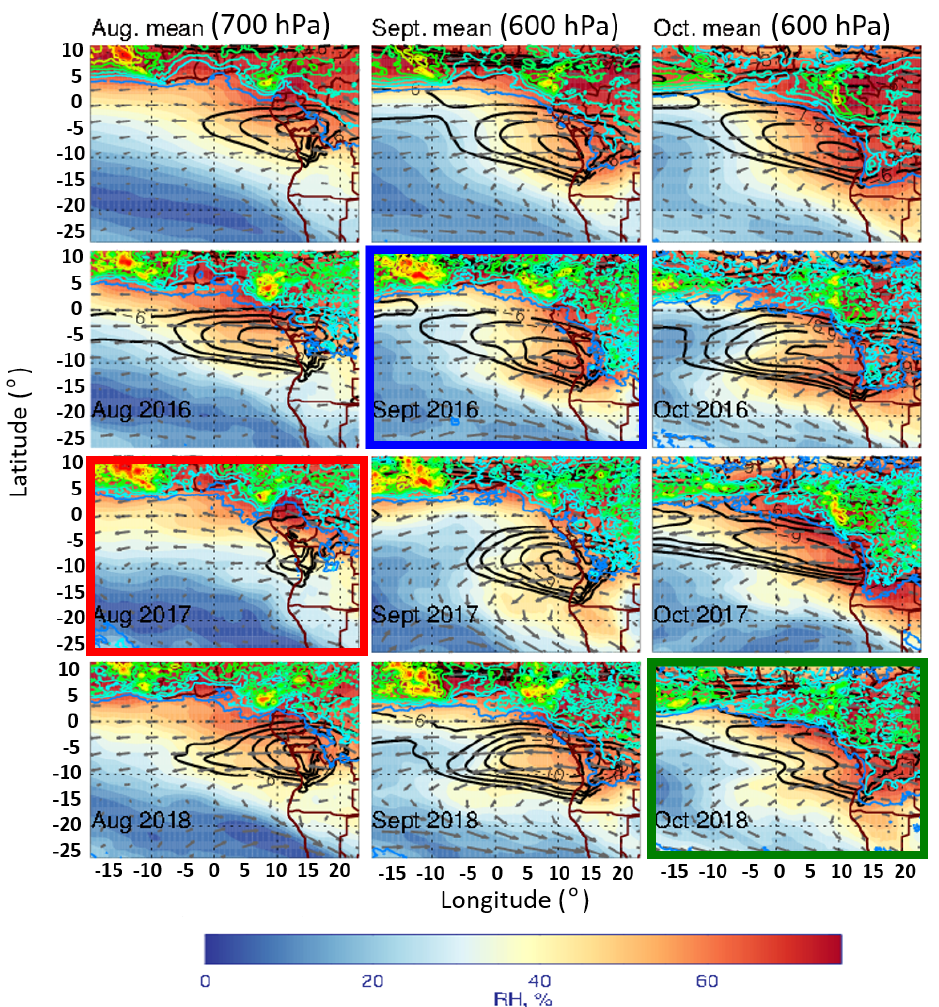
Figure 3. Maps of zonal wind (black contours; ms − 1 ; values are given as ≤ − 6ms − 1 , with a 1ms − 1 interval), RH (shading; percent), and horizontal wind vector at 700hPa for August and at 600hPa for September and October. Precipitation (color contours, from light blue (0.05) to red (1.05), with 0.1 intervals in millimeters per hour; hereafter mmh − 1 ) is overplotted for the climatological mean (2000–2018) and the ORACLES deployment months (August 2017, September 2016, and October 2018). The colored boxes (red, blue, and green) indicate the month of the ORACLES